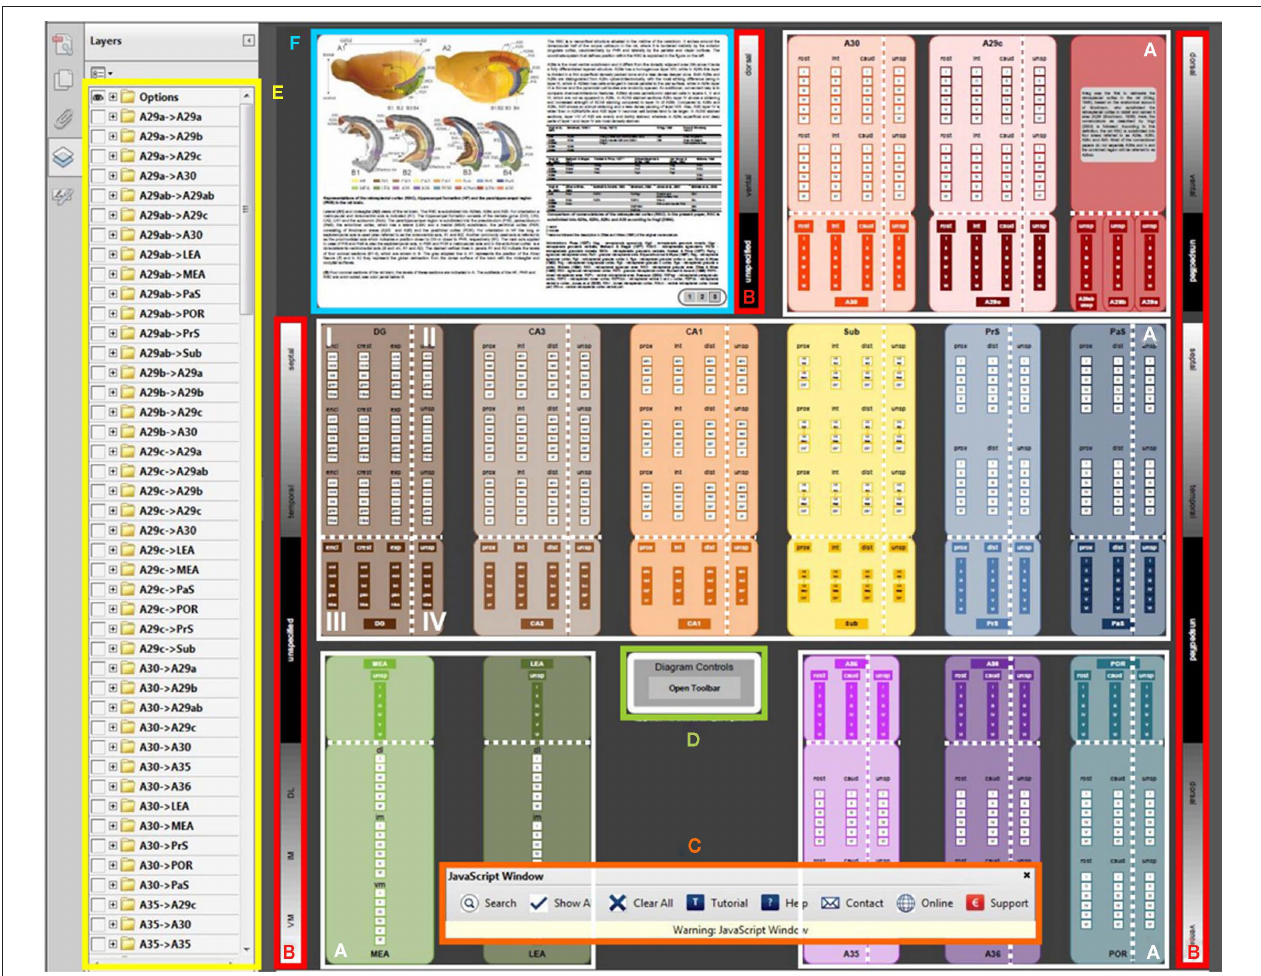
quadrant II , the information of the vertical axis and the layers are specified, but no details of the horizontal axis are presented. In quadrant III the horizontal axis and the layers are represented, while in quadrant IV , only layer information is present. (C) The interactive connectome allows visualization of detailed connectivity patterns within and between sub-regions. To search for connections, use the search button on the toolbar (C) . The toolbar has eight buttons (from left to right): Search for connections, show all connections, clear all connections, a short tutorial on how to search for connections, a help section, contact information, a link to the project website www.temporal-lobe.com and information about how to support this project. (D) If the toolbar is closed, clicking the “open toolbar” button will restore it. (e) After a search is carried out, the retrieved connections will be drawn in the diagram between the appropriate areas and quadrants. Additionally, an eye-icon will appear in the layers panel on the left (e) . This is an alphabetically sorted list of “from → to” connection groups that can also be switched on or off manually. In front of each group is a “ + ” icon. Clicking this icon expands the list of individual connections that make up the group, allowing one to select connections originating from a specific cortical layer or according to a specific three-dimensional projection pattern. (F) The figure panel provides a detailed anatomical description of the retrosplenial cortex, the hippocampal formation and the parahipppcampal region, together with translation tables for nomenclature. Use the buttons in this panel to switch between the